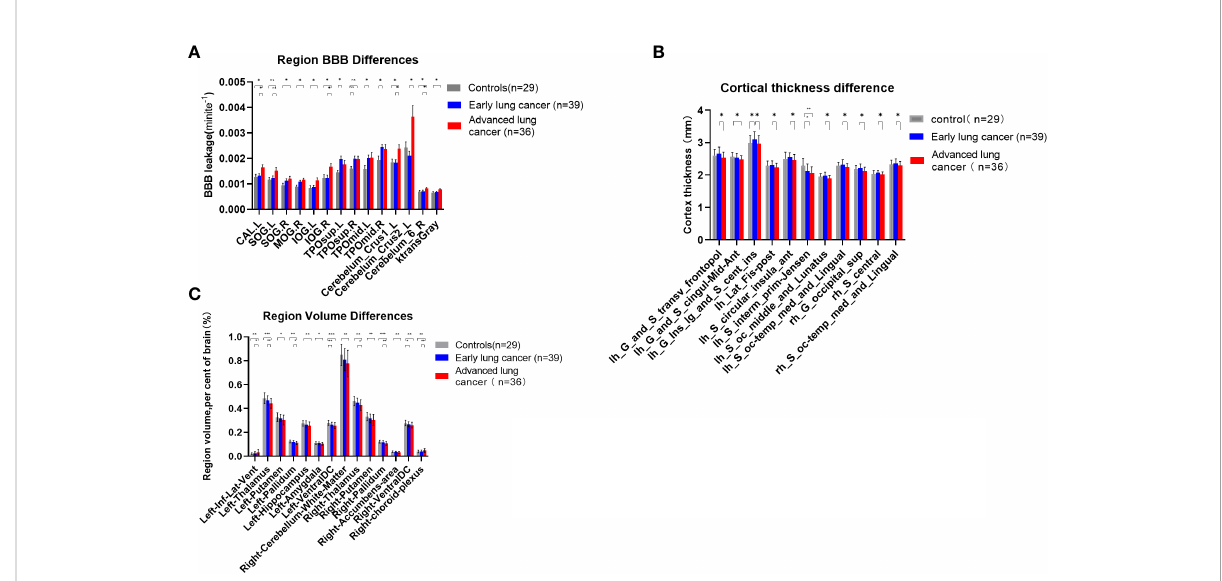
FIGURE 3 (A) Comparisons of BBB leakage between patients with LC at different stages and HCs. Quantify the leakage rate of BBB in different brain regions, and there were signi fi cant differences in 8 brain regions between patients with aLC and HCs (p < 0.05), which revealed the existence of BBB leakage in patients with aLC. There was no statistical difference between SOG.R and TPOsup.R after correction. (B) Comparisons of cerebral cortex thickness between patients with LC at different stages and HC. There was signi fi cant difference between patients with aLC and patients with eLC (p < 0.05). The thickness of 9 cerebral cortices decreased in patients with aLC. There was no statistical difference between the cerebral cortex of patients with LC and HC, but the cortex of patients with eLC showed an increasing trend and a decreasing trend in aLC. (C) Comparisons of subcortical structure volume between patients with LC at different stages and HC. There was signi fi cant difference between HC of patients with aLC (p < 0.05). In patients with aLC, the volume of 13 subcortical structures decreased, while the volume of 1 structure increased. The volume of bilateral VentralDC showed volume reduction in patients with eLC. The volume of 6 subcortical structures in patients with aLC was smaller than that in patients with eLC, while the volume of one structure increased in patients with aLC. *P<0.05, **P<0.01, ***P<0.001; ns, no statistical